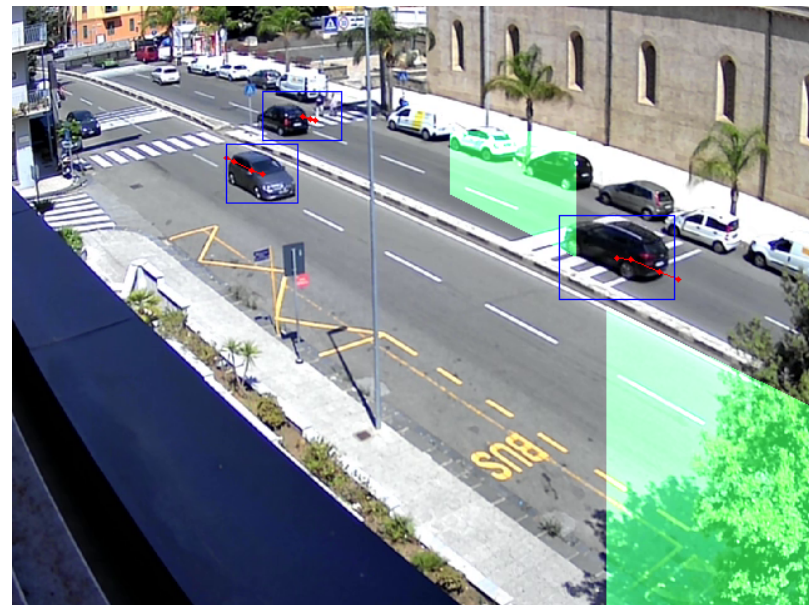
Figure 4. Captured frame with moving objects identified. Objects hitting the green area are counted as moving objects. The pseudo-code of the described algorithm is provided in the Algorithm